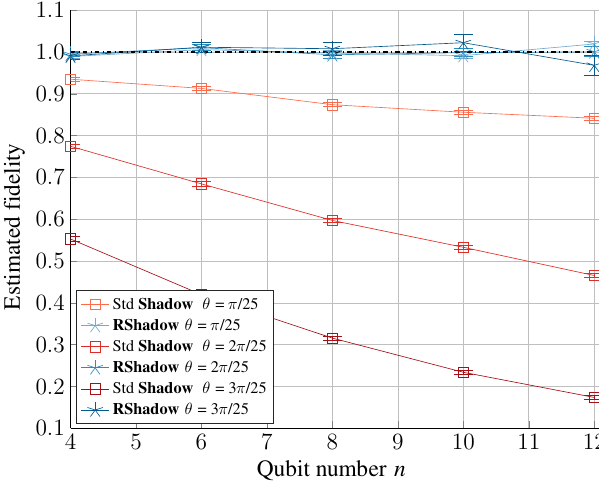
FIG. 3. Comparison of the GHZ fidelity estimation using stan- dard Shadow and RShadow with respect to different qubit numbers n . Here, we assume that all the qubits will experi- ence a local X -rotation error U X (θ) = e − i θ X with θ = π/ 25, 2 π/ 25, and 3 π/ 25. In the experiment, we set the number of